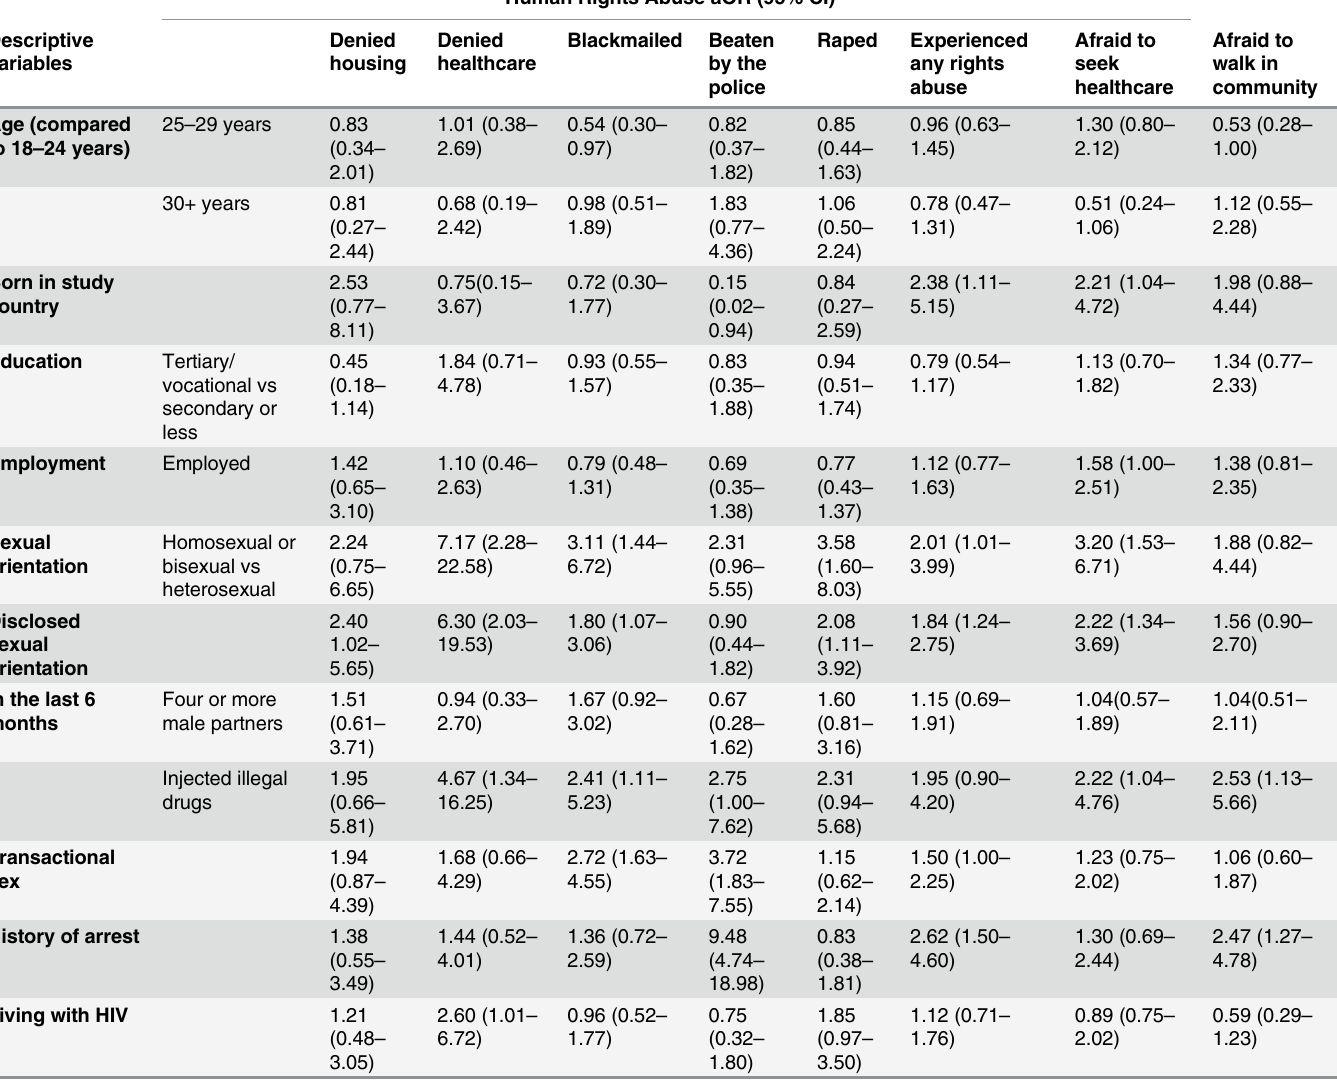
Table 5. Multivariate covariates for human rights